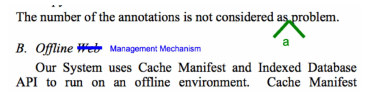
Fig. 8. Editing and inserting sentences.